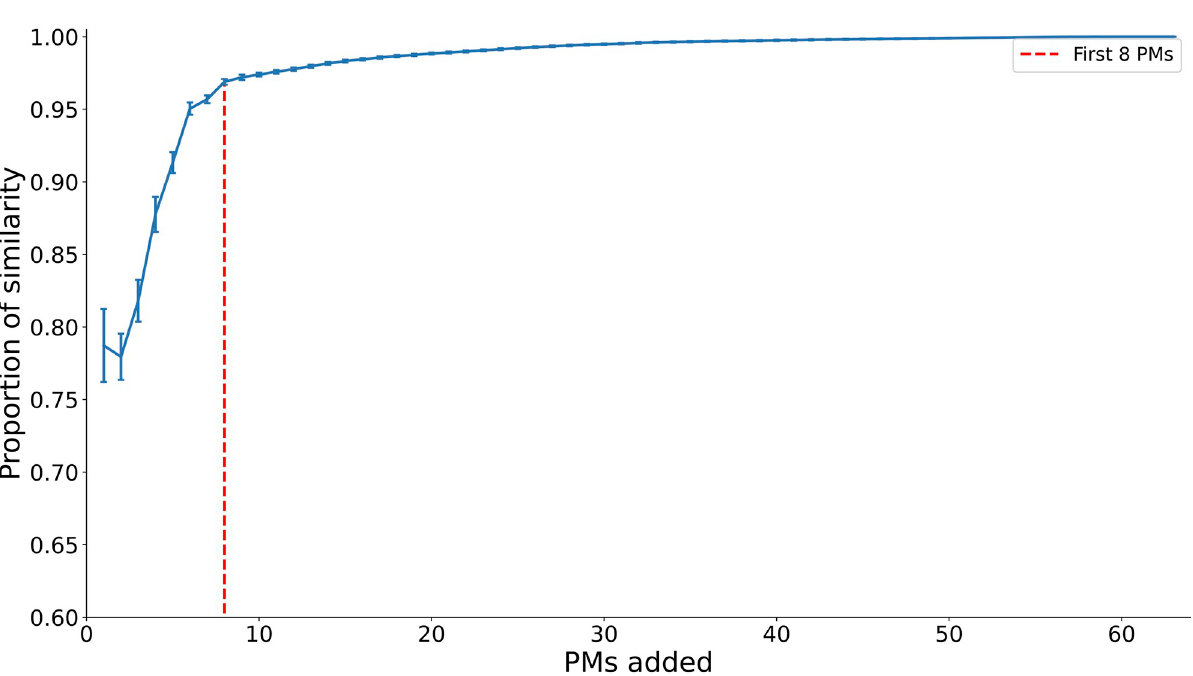
Fig 6. Mean cross-projection similarity between PM subspaces across signers. Mean was computed across the six signers, error bars indicate standard errors.